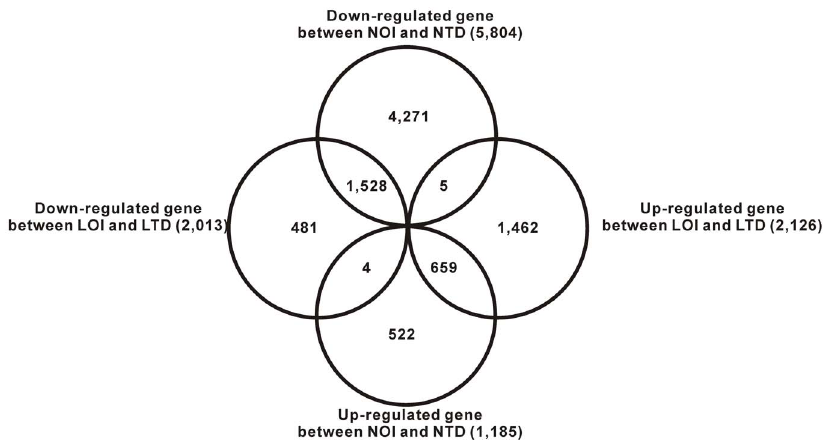
Figure 3. Number of DEGs in the different genotypes. The numbers of DEGs that were exclusively up- or down-regulated in one genotype are shown in each circle. The numbers of DEGs with common or opposite tendency of expression changes between different genotypes are shown in the overlapping regions. The total numbers of up- or down-regulated gene in each genotype are shown outside of the circles.